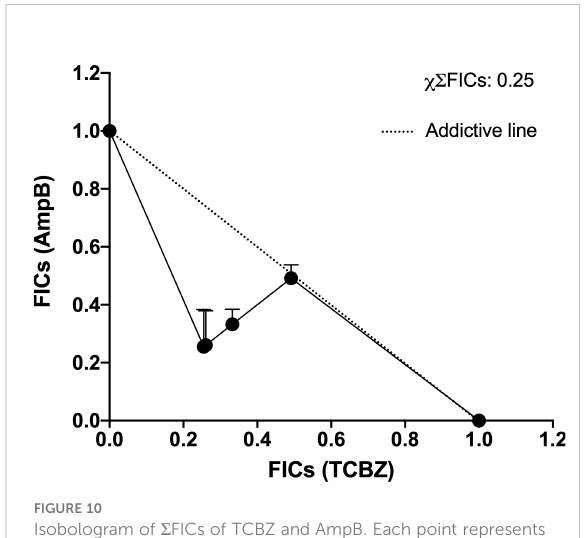
FIGURE 10 Isobologram of S FICs of TCBZ and AmpB. Each point represents FICs of each proportion (10:1, 5:1, 4:1, 1:1 for TCBZ and AmpB, respectively). The dotted line represents the addictive line. The result of cS FICs of all ratios analyzed is at the upper